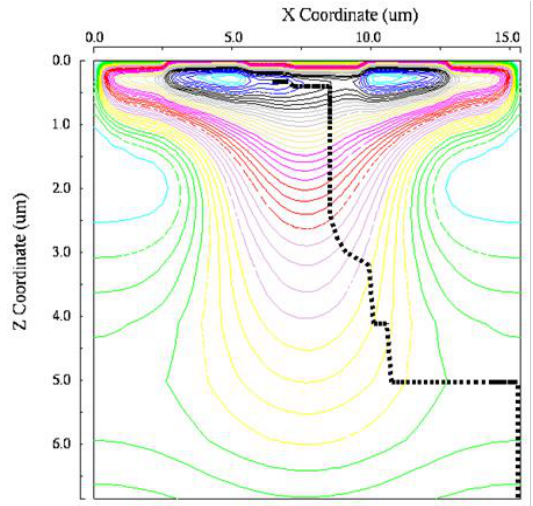
Figure 14. Selective collection of an electron generated at the ―right‖ corner by the ―left‖ collection gate (0 < z < 6.9 µm).